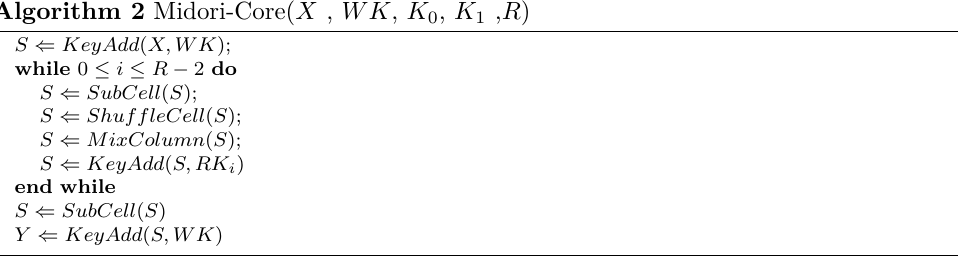
Algorithm 2 Midori-Core( X , WK , K 0 , K 1 , R )